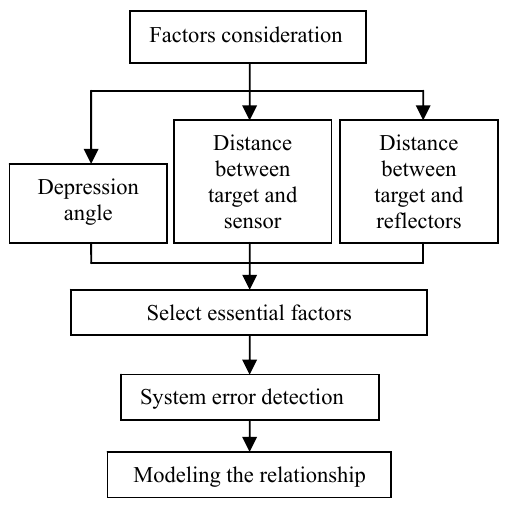
Figure 3. The experiment flow path